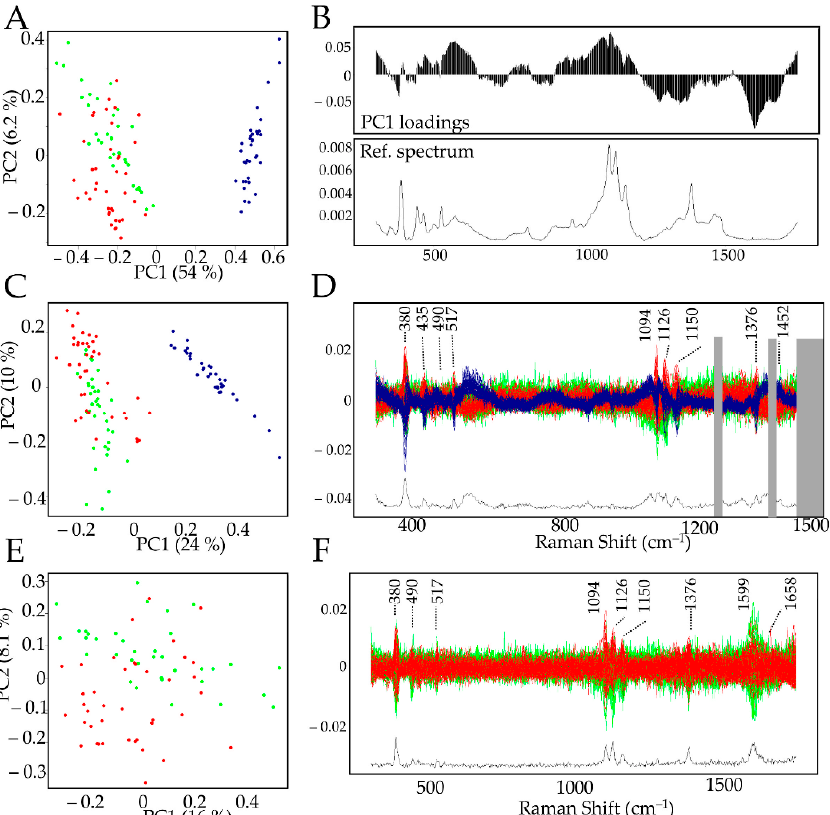
Figure 3. PCA analysis of xylem and BF G ‐ layer Raman spectra. ( A ): Biplot of the full dataset. BF (blue dots) and xylem G ‐ layer Raman spectra (red/tension and green/opposite dots) were clearly separated along the PC1 (54%) axis. Other PCs did not lead to better discrimination of xylem G ‐ layer tension side from the opposite side. ( B ): PC1 loadings along with the average spectrum from BF. ( C , D ): Biplot and centered spectra of full data set modified to remove aromatics bands [1270–1421–peaks >1510 cm –1 ], BF (blue dots) and xylem G ‐ layer Raman spectra (red/tension and green/opposite dots). ( D ): Xylem G ‐ layer (red, green) and BF G ‐ layer (blue) spectra showing removed aromatic bands (grey boxes). E, F: Biplot and centered spectra. BF dataset was removed in order to compare only xylem G ‐ layers (red/tension and green/opposite dots).